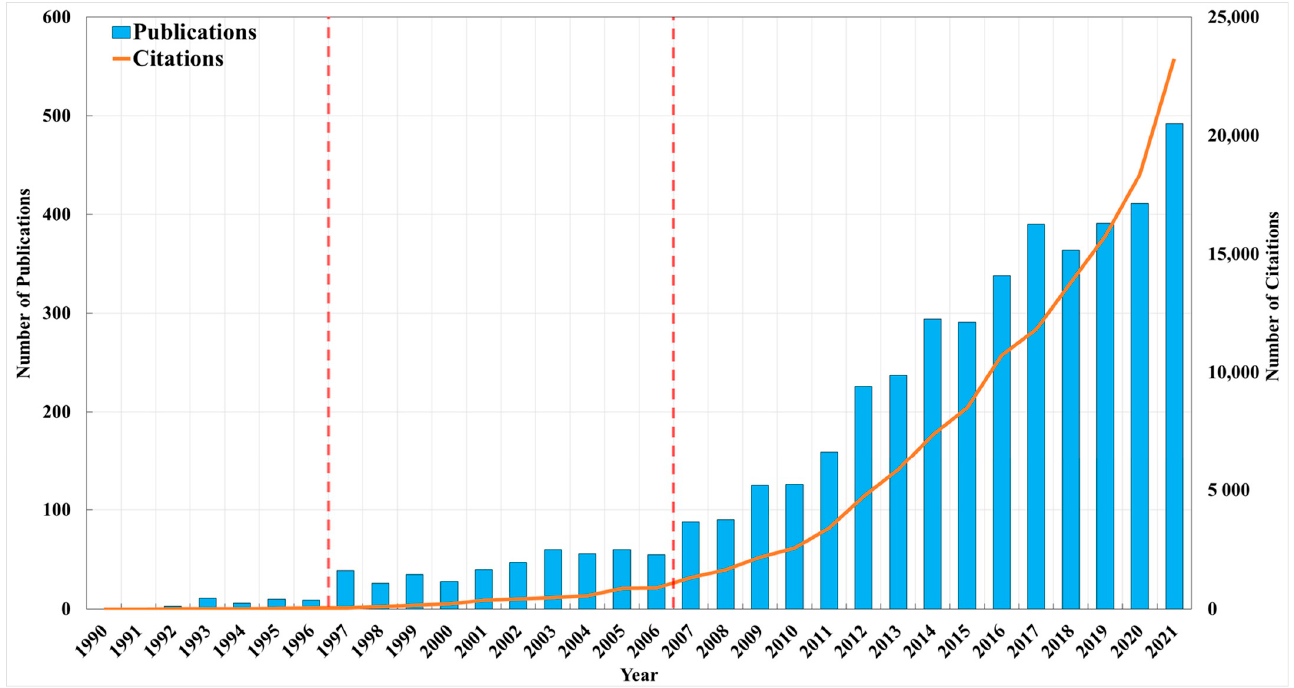
Figure 1. The number of publications and citations.